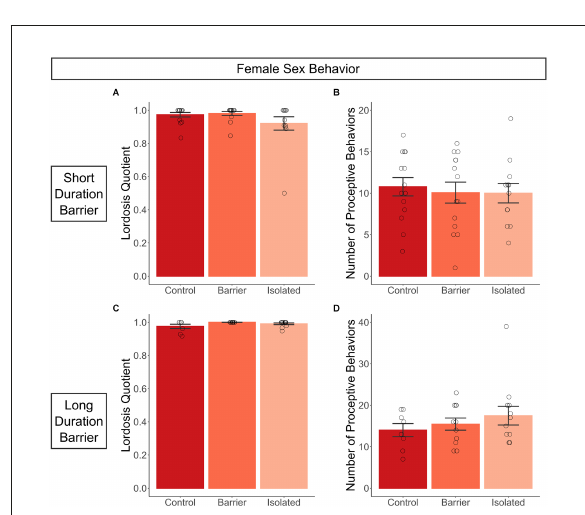
FIGURE4 Juvenile play deprivation has no effect on copulatory behavior in adult females. Lordosis quotient (A) , the number of lordoses exhibited by the female divided by the total number of mounts by the stimulus male, and the number of proceptive behaviors (B) , the total number of hops, darts, and solicitations, exhibited in a 10-min test with a sexually experienced adult male stimulus rat on P63 for the short duration barrier study, with the same measures shown for the long duration barrier study in (C,D) . Bars indicate group means ± SEM, and open circles represent data from individual rats. n = 7–14 per